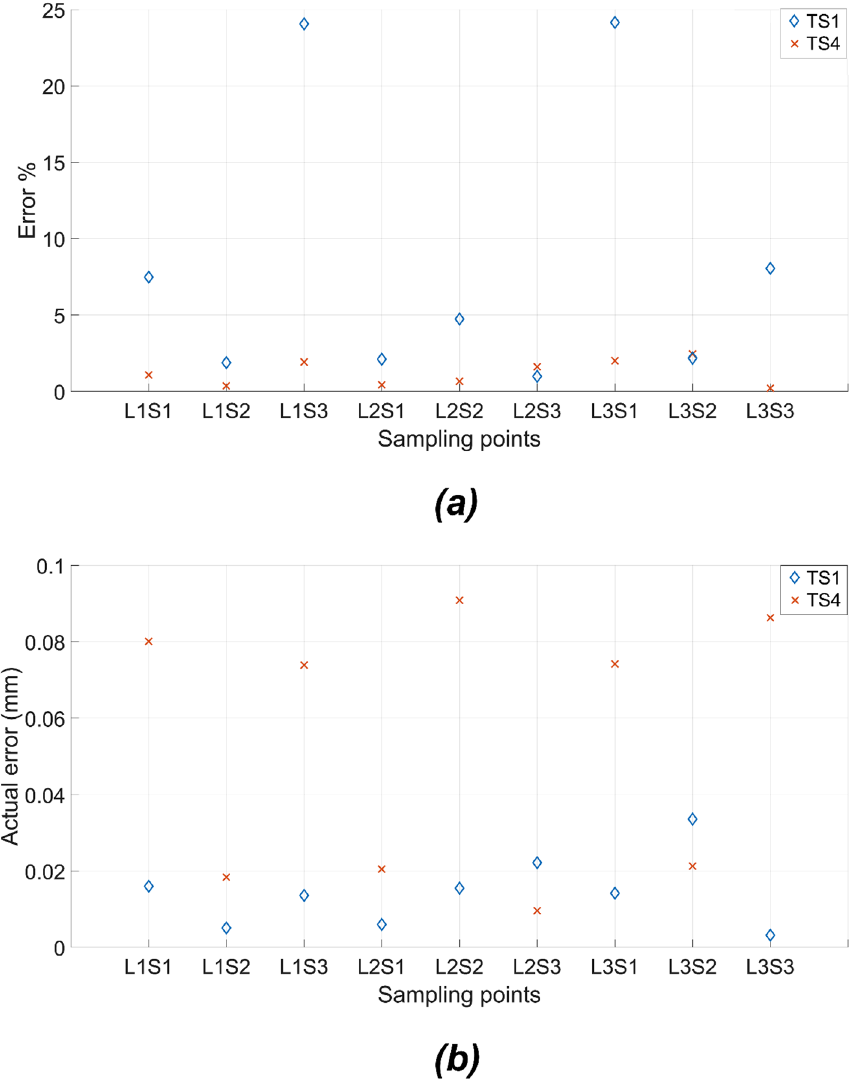
Figure 18. The mean of the differences between the deflection at nine sampling points and the corresponding target deflections for TS1 and TS4 in 20 voxel asymmetric single void beam model is expressed as ( a ) percentage and ( b ) actual difference in the deflection. Each data point corresponds to the mean value of 5 independent